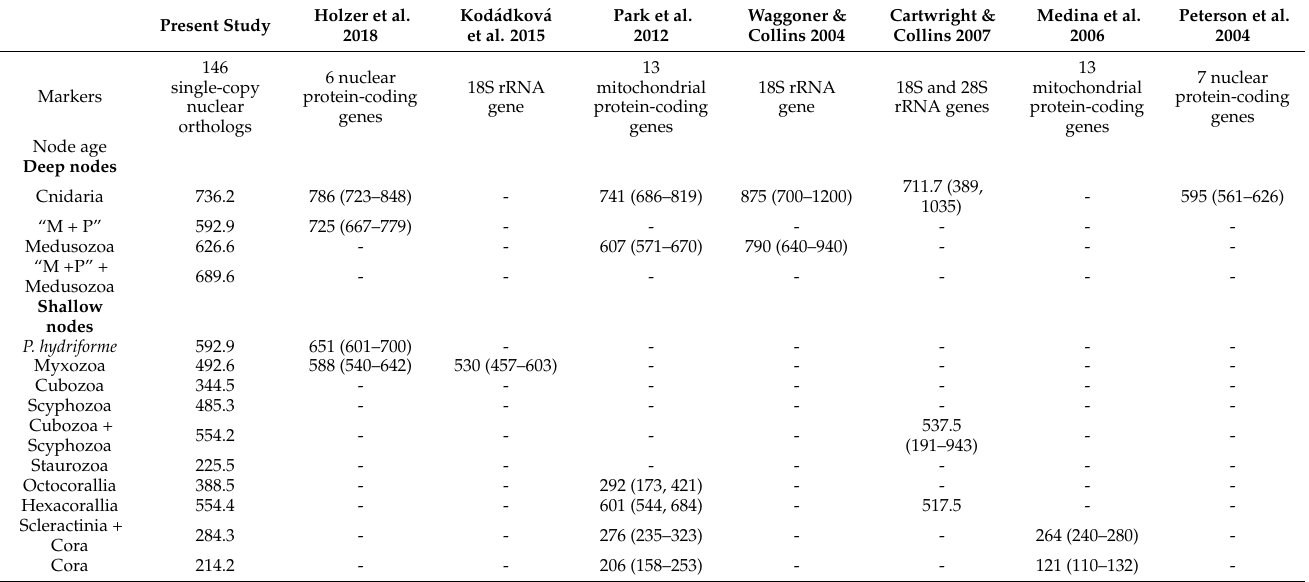
Table 3. Comparison of divergence times for major nodes shared across eight studies. Numbers in the parentheses represent the median times and 95% HPD interval (Mya). “-” = Not available. “M